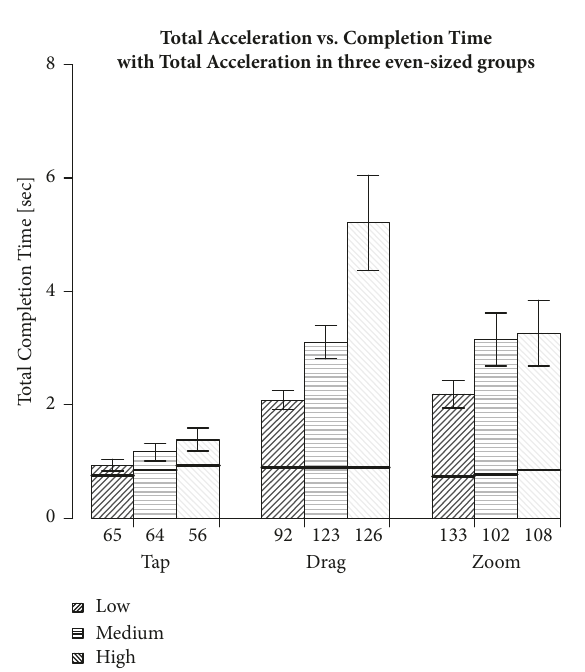
Figure 22: Total acceleration depending on the total task comple- tion time (inversed axes compared to Figure 20). The number of samples is provided below the histograms.